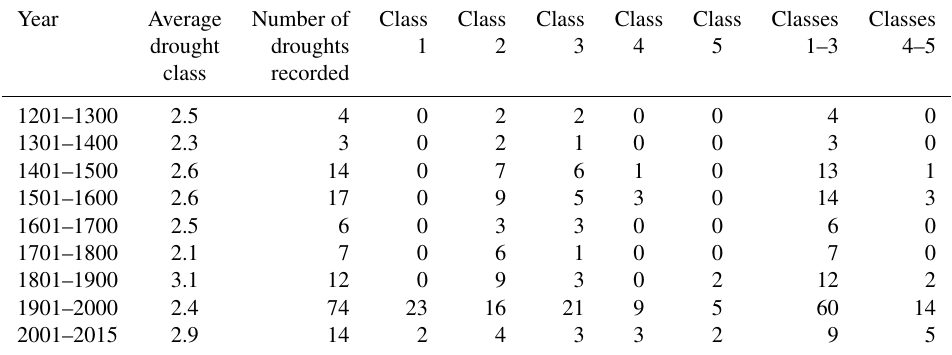
Table 5. The frequency of droughts in Shenyang since 1200 and associated drought classes (see Table 4). The average drought reflects the average class achieved for each period.